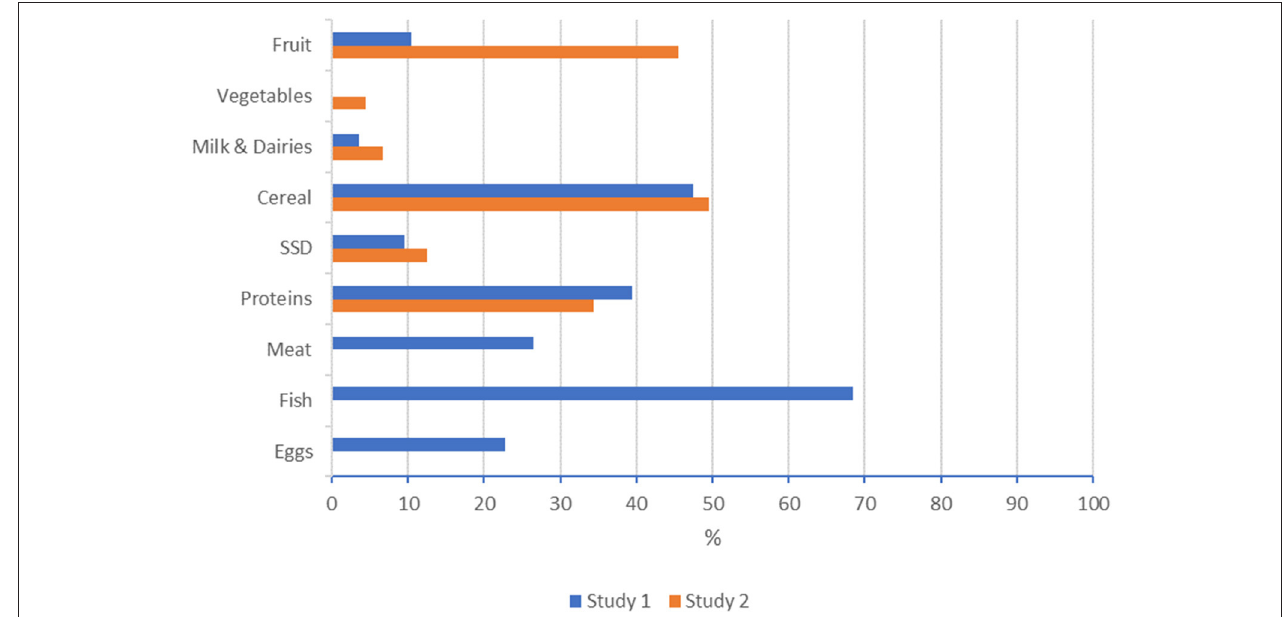
FIGURE 1 | Comparison of adherence to SSN guidelines between Study 1 and Study 2, Switzerland